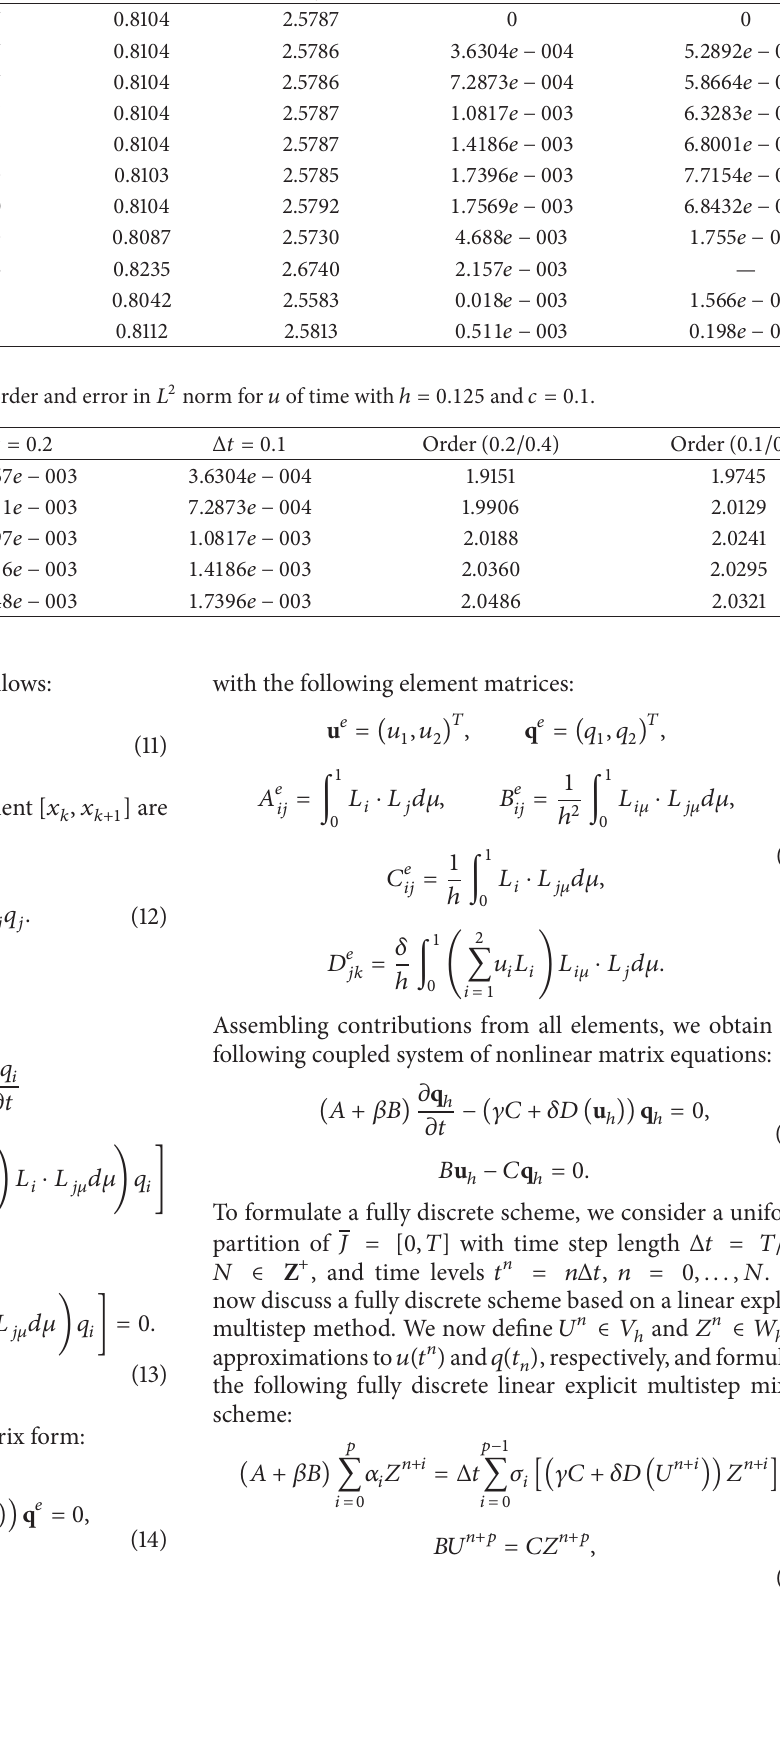
Table 1: Solitary wave Amp. 0.3 and the errors in 𝐿 2 and 𝐿 ∞ norms for 𝑢 , 𝑄 1 , 𝑄 2 , and 𝑄 3 at 𝑡 = 20 , ℎ = 0.125 , Δ𝑡 = 0.1 , and −40 ≤ 𝑥 ≤ 60 . Method